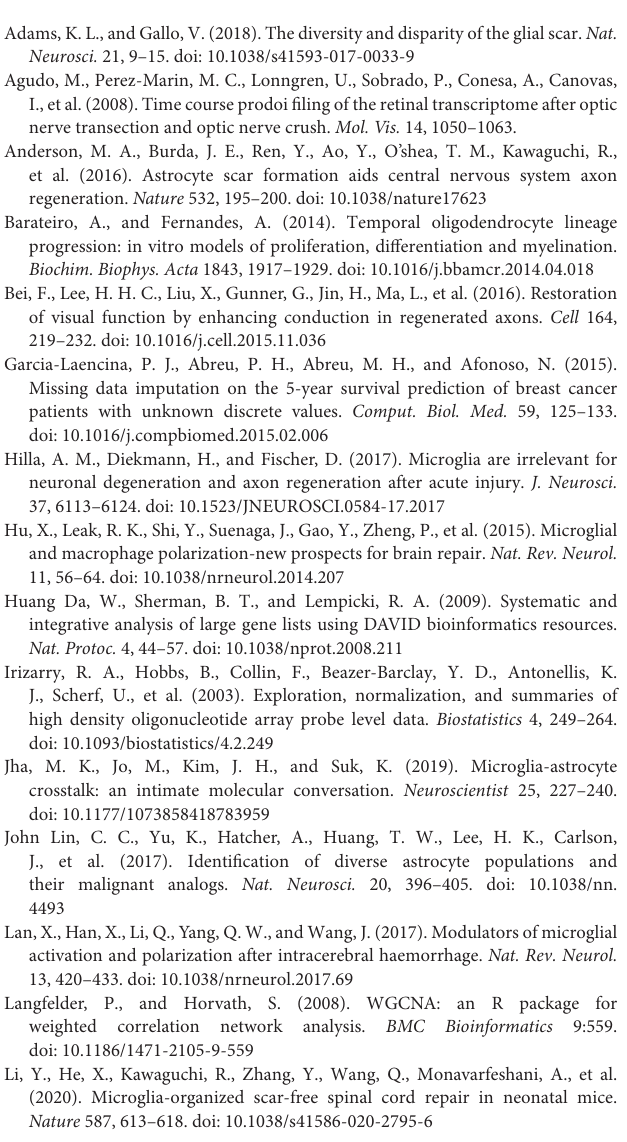
Supplementary Figure S5 | Cell type enrichment analyses for M6-M9 modules. (A–D) Cell type enrichment analyses for M6-M9 modules. Supplementary Figure S6 | Visualized network of each module. (A–D) Visualized networks based on top 250 gene connections of M1 (A) , M3 (B) , M7 (C) , M9 (D) , and M8 (E) modules. The top 5 hub genes based on degree in each module were shown. Supplementary Figure S7 | Other markers expressed by A1 and A2 reactive astrocyte. Supplementary Table S1 | GO terms of each module. Supplementary Table S2 | Cell type terms of each module. Supplementary Table S3 | DEGs at each time point after